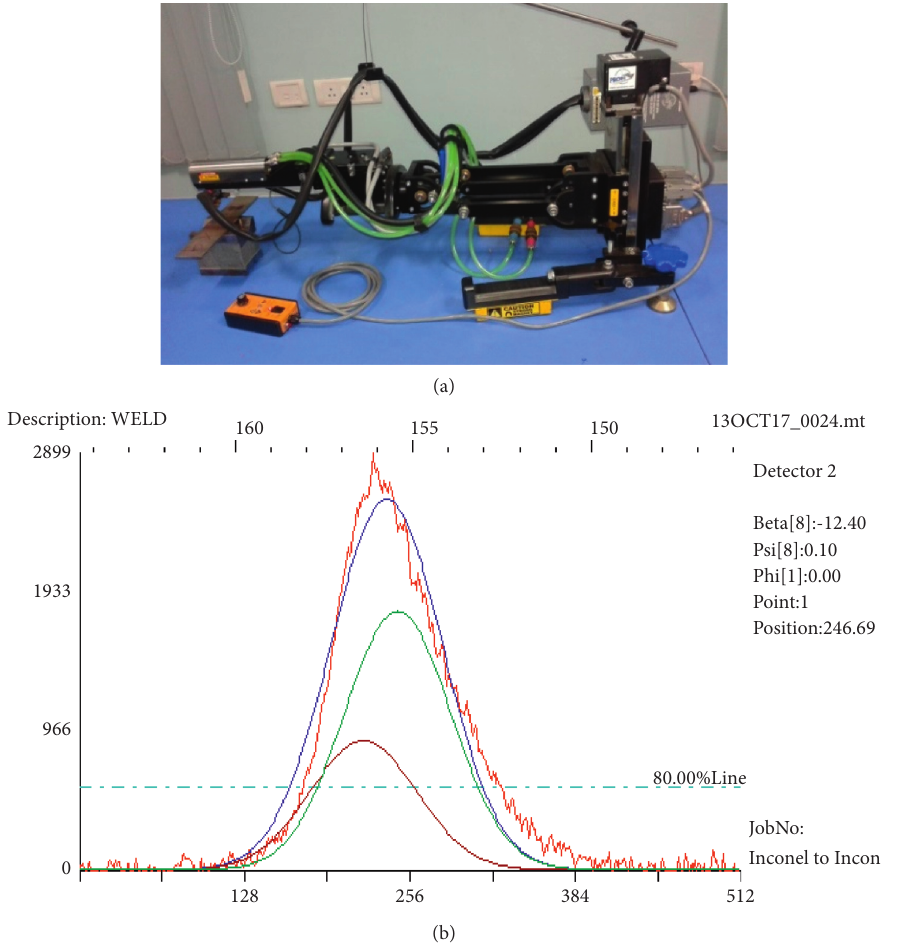
Figure 3: Residual stress measuring instrument.